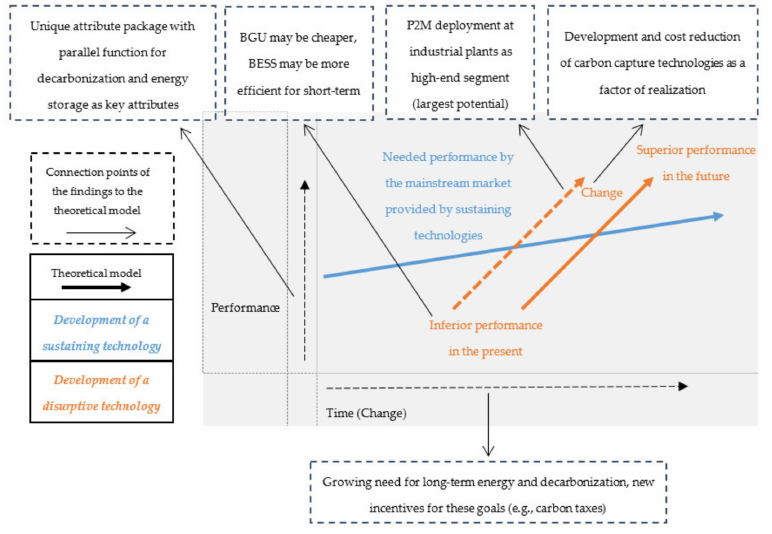
Figure 5. The disruption potential of P2M technology (main conclusions aligned with the research